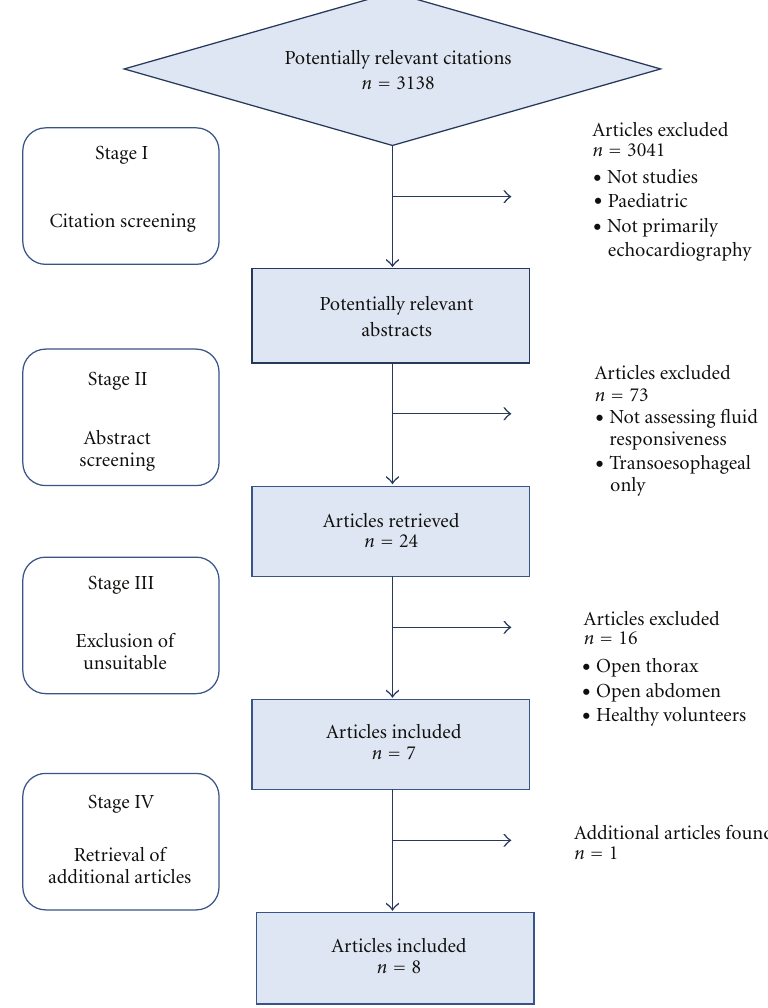
Figure 2: Citation filtering